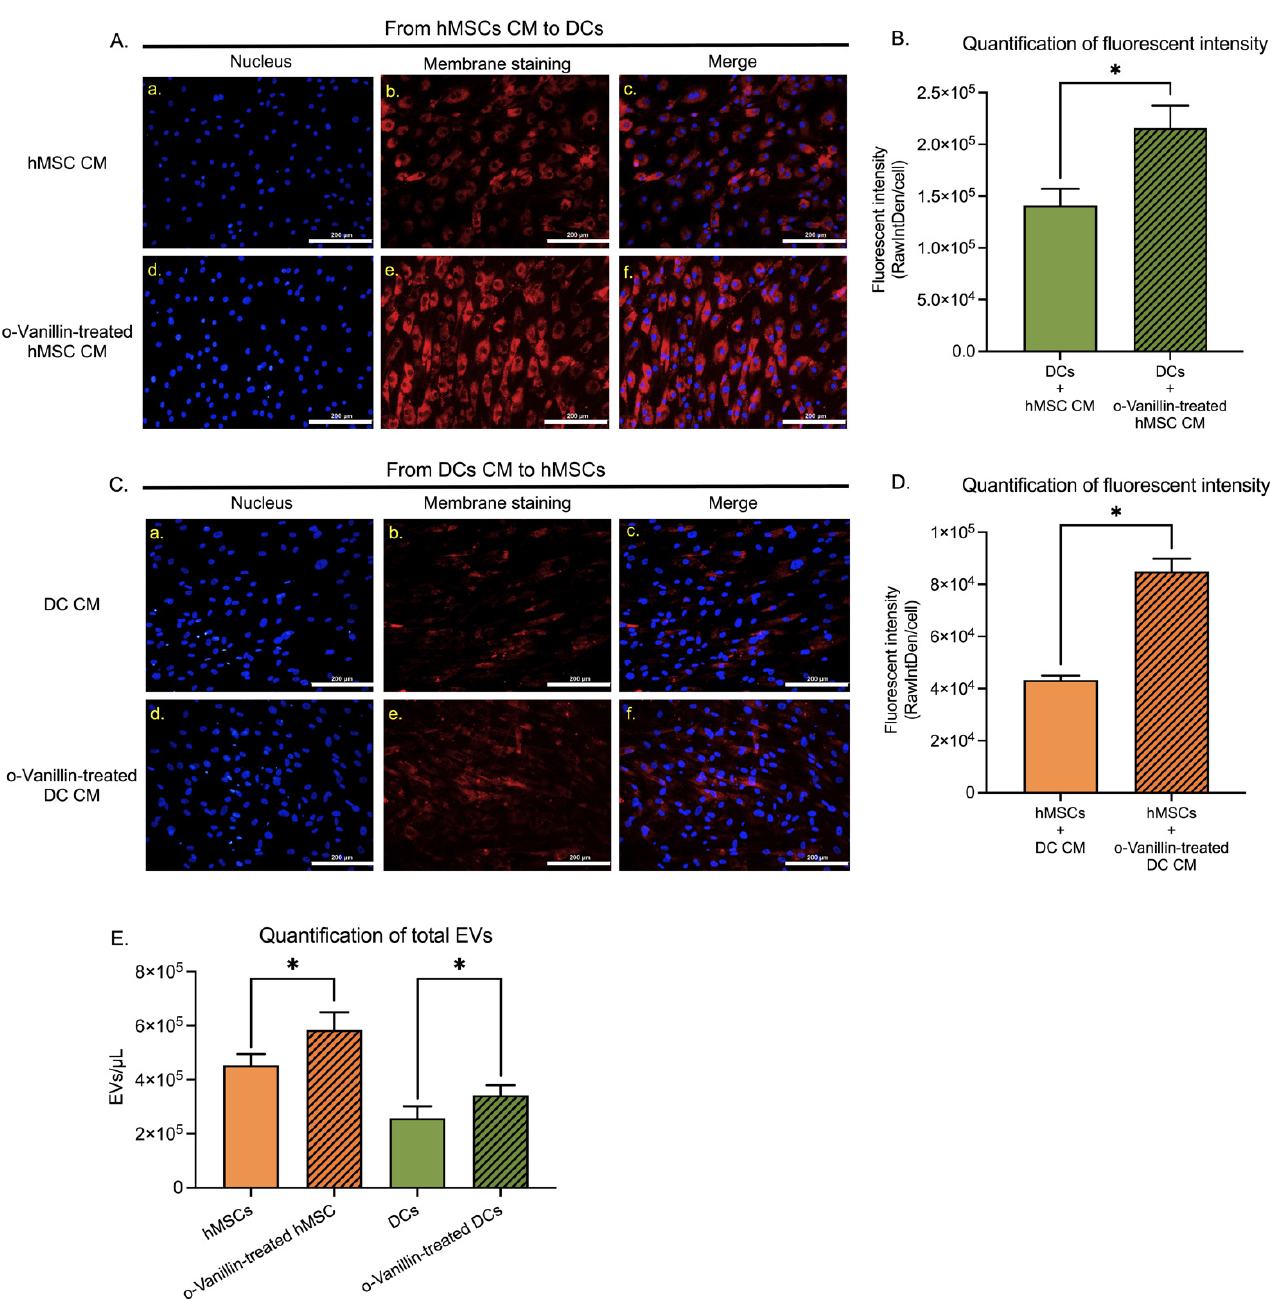
Figure 4. Transfer and uptake of EVs by hMSCs and DCs via CM. ( A ) Representative images showing nuclear (blue) ( A-a ), plasma membrane (red) ( A-b ), and merge staining ( A-c ) of DCs cultured in the CM of red-labeled untreated hMSCs ( A-a–c ) and o-Vanillin-treated hMSCs ( A-d–f ). Scale bars: 200 µm. n = 3. ( B ) Quantification of cellular fluorescence intensity in the two groups of DCs exposed to the CM of labeled untreated and o-Vanillin-treated hMSCs. n = 3. ( C ) Photomicrographs showing nuclear, plasma membrane, and merge staining of hMSCs cultured in the CM of labeled untreated ( C-a–c ) and o-Vanillin-treated ( C-d–f ) DCs. Scale bars: 200 µm. n = 3. ( D ) Quantification of cellular fluorescent intensity of hMSCs cultured in the CM of labeled untreated and o-Vanillin-treated DCs. n = 3. ( E ) Quantification of the total numbers of EVs generated by labeled o-Vanillin-treated hMSCs and DCs using nano-flow cytometry. The total event window is set to 110–1300 nm using ApogeeMix calibration beads. n = 4. Values are presented as mean ± SEM. * indicates a statistically significant change assessed by a paired t- test in ( B , D and E ): p < 0.05. Additionally, see Figure S5.